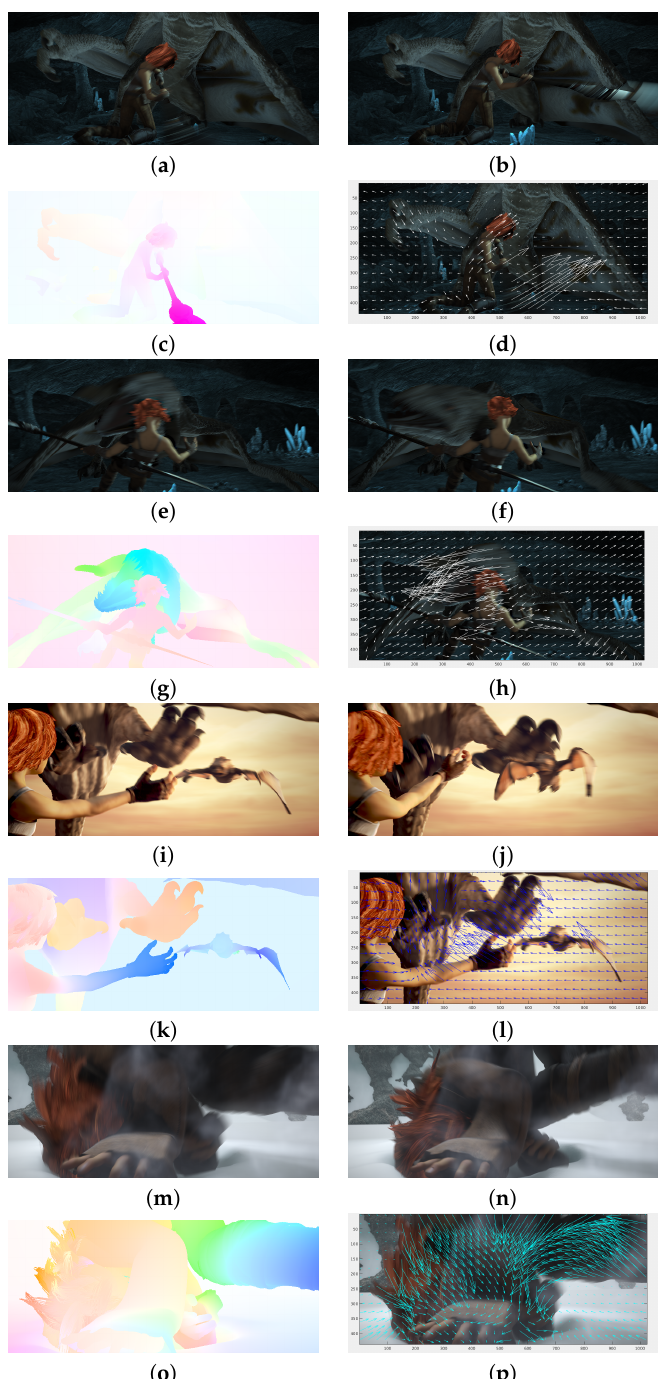
Figure 10. Examples of images of the MPI-Sintel database video sequence. ( a , b ) frame_0010 and frame_0011, ( c ) color-coded ground truth optical flow of the cave_4 sequence, ( d ) ground truth represented with arrows. ( e , f ) frame_0045 and frame_0046, ( g ) color-coded ground truth, and ( h ) arrow representation of optical flow of the cave_4 sequence, ( i , j ) frame_0030 and frame_0031, ( k ) color-coded ground truth optical flow, ( l ) arrow representation (in blue) of the temple3 sequence. ( m , n ) frame_0006 and frame_0007, ( o ) color-coded ground truth and ( p ) arrow representation (in green) ground truth optical flow of the ambush_4